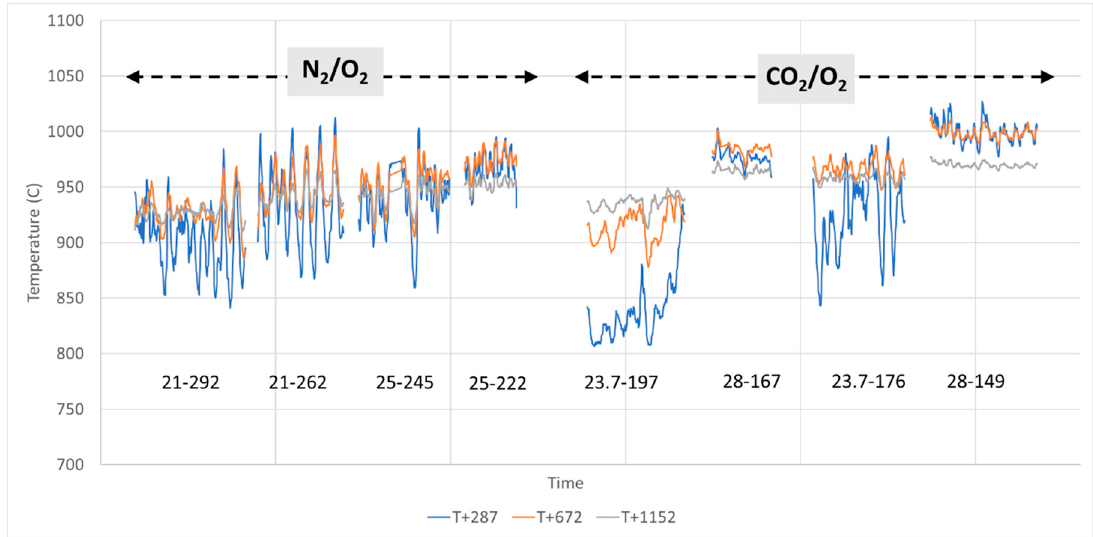
Figure 2. Temperature time trace examples (e.g., T+287 = thermocouple placed 287 mm above the grate, see Figure 1) for different oxidizers as specified under each time segment (e.g., first segment on the left is 21% O 2 in N 2 at a flow rate of 292 NL/min).